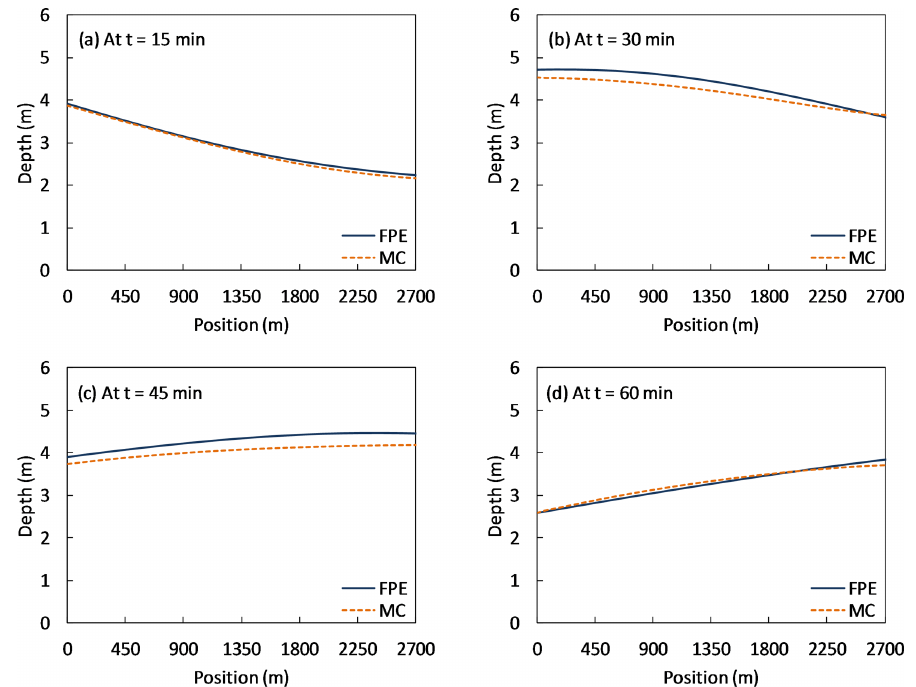
Figure 4. Comparison of the ensemble average flow depth obtained by the FPE methodology and the MC approach as a function of channel location, at different times.